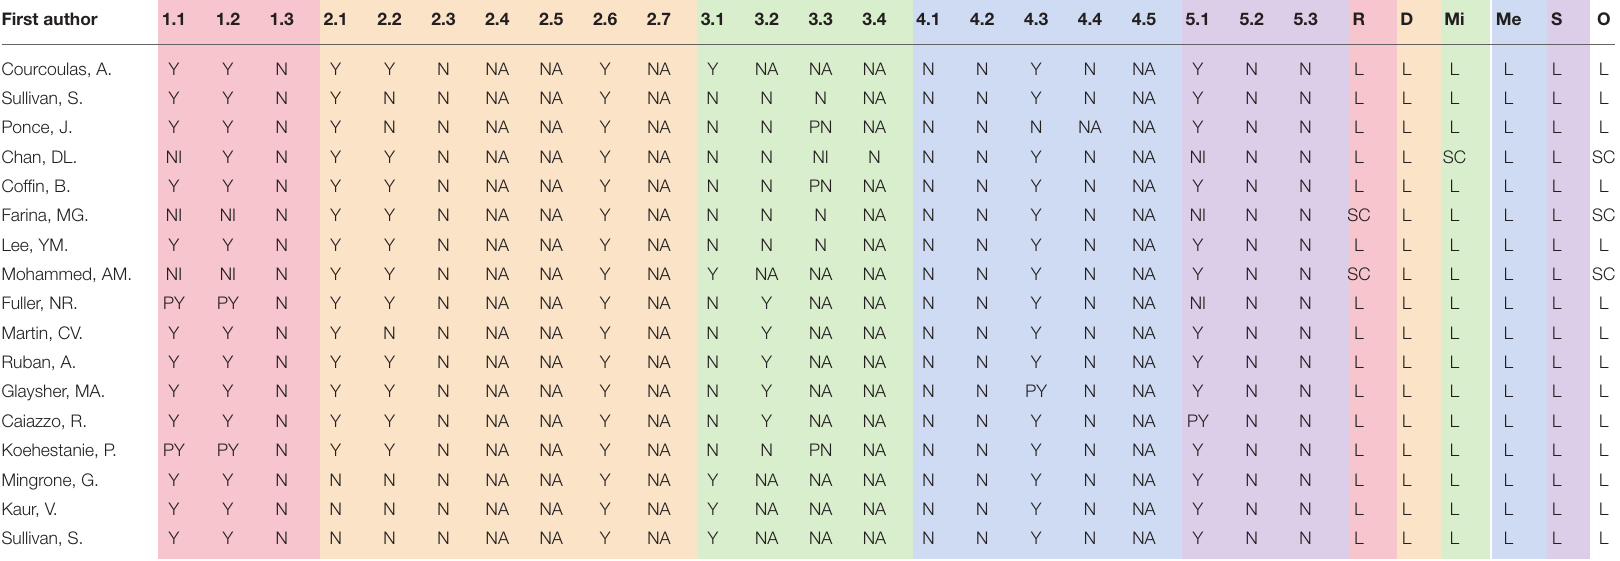
TABLE 7 | Risk of bias assessment for included randomized controlled